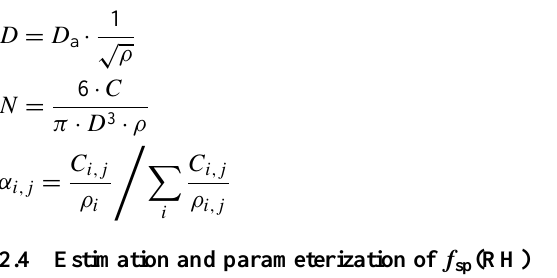
Table 3. Computational codes of the calculations